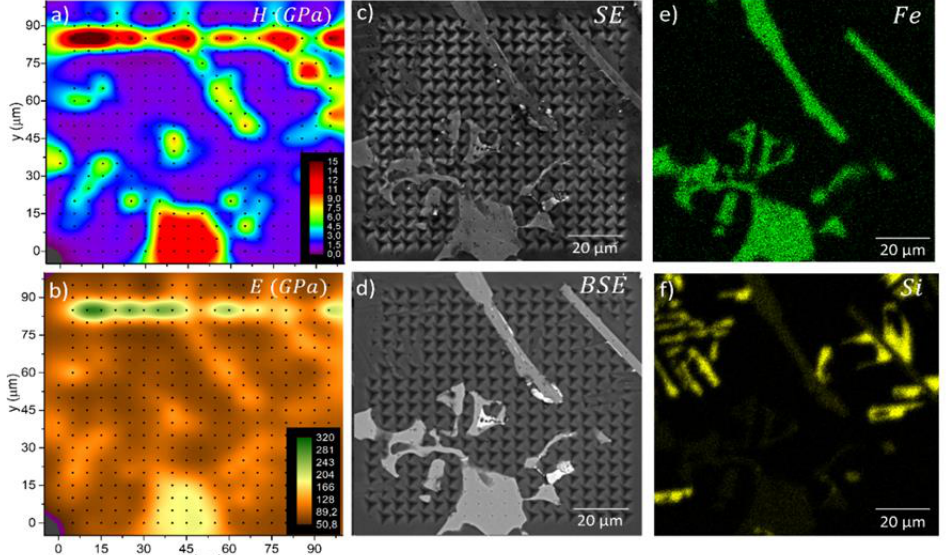
Figure 9. Instrumented nanoindentation analysis with a 20 × 20 matrix using the fast H-E method. ( a ) Hardness; ( b ) elastic modulus maps of a region with different types of phases, where each point represents an identification; ( c , d ) SEM-SE and SEM-BSE images; ( e , f ) EDS-Map of Fe and Si.